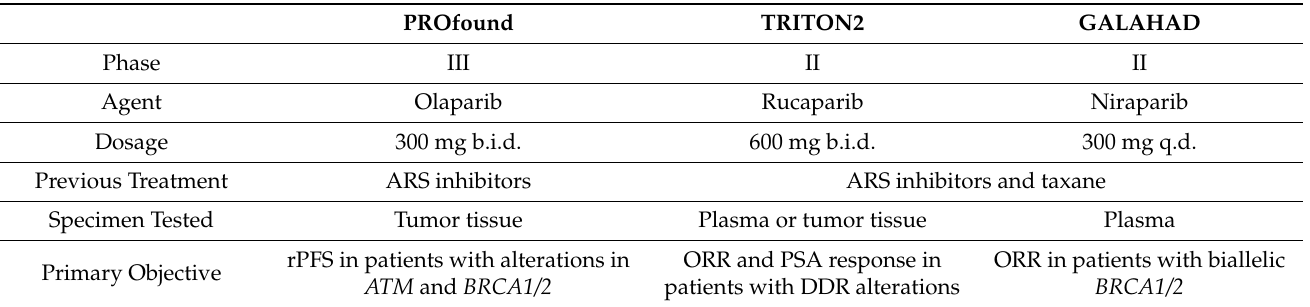
Table 2. Principal PARP inhibitors’ monotherapy studies in